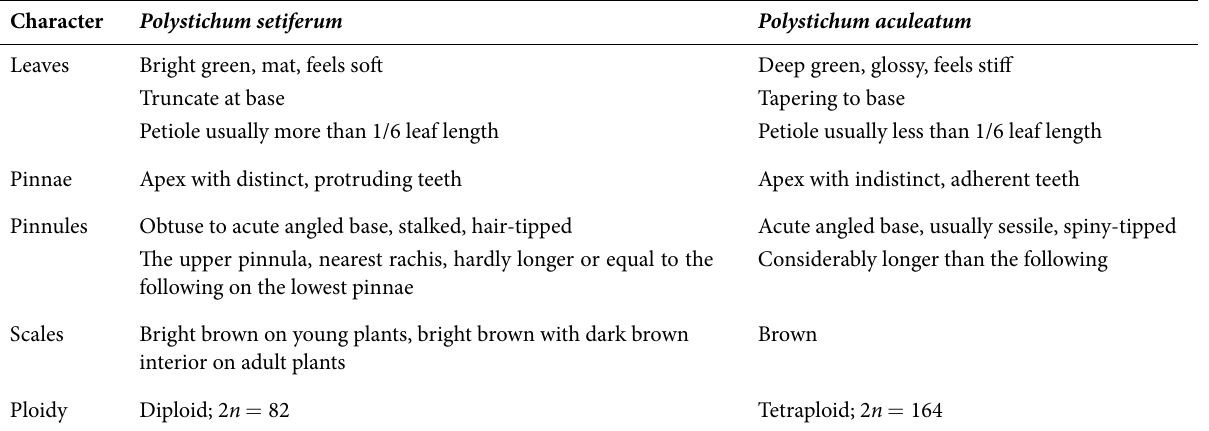
Figure 1 Distribution of Polystichum setiferum at the northeastern limit of its range based on verified herbarium specimens (circles), literature data (triangles), and the present study (square). Historical records were based on Ekrt (2016) and updated from Kaplan et al. (2017).